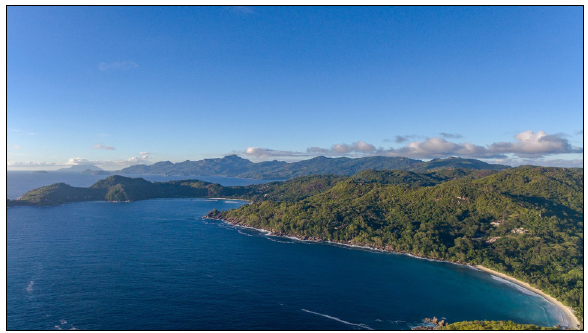
Source: CC-BY-2.0 Wikimedia Commons Figure 3: Jagged skyline of Mahé Island, Seychelles, which was interpreted by du Toit 7 as having formed by block faulting of a peneplained continental granitic terrain.